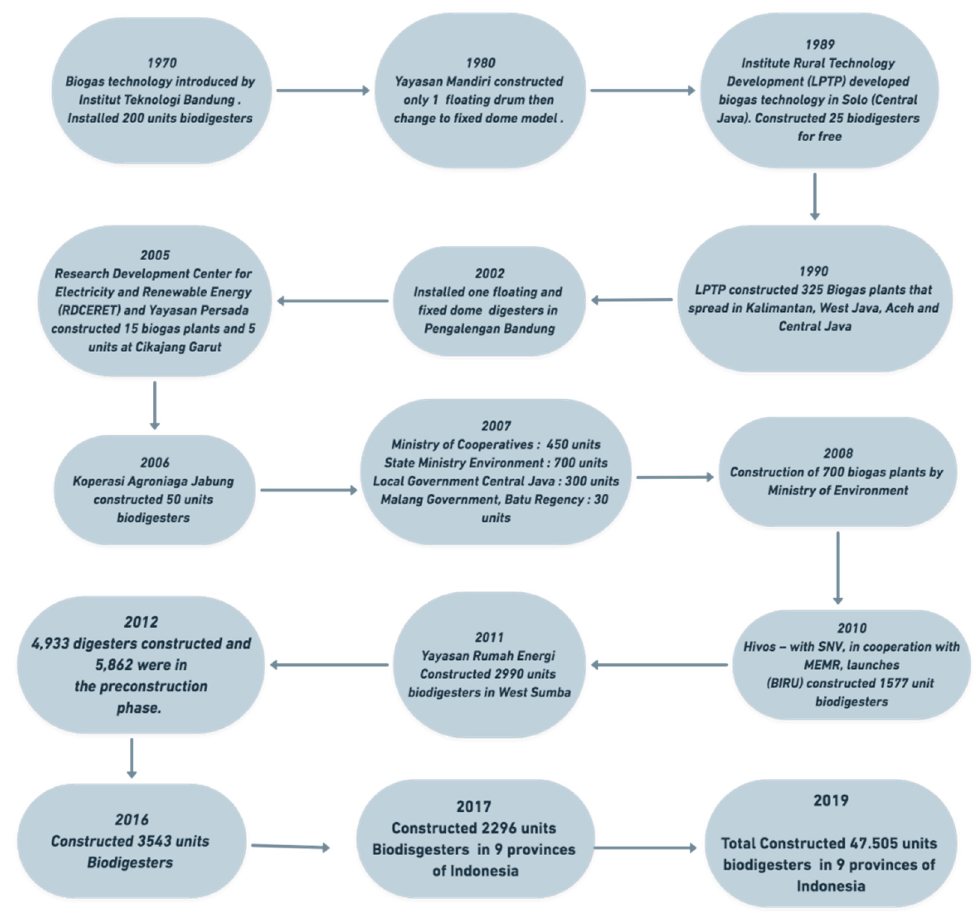
Figure 5. Indonesia’s biogas production from 1970–2019 (modified by author based on [5,16]).